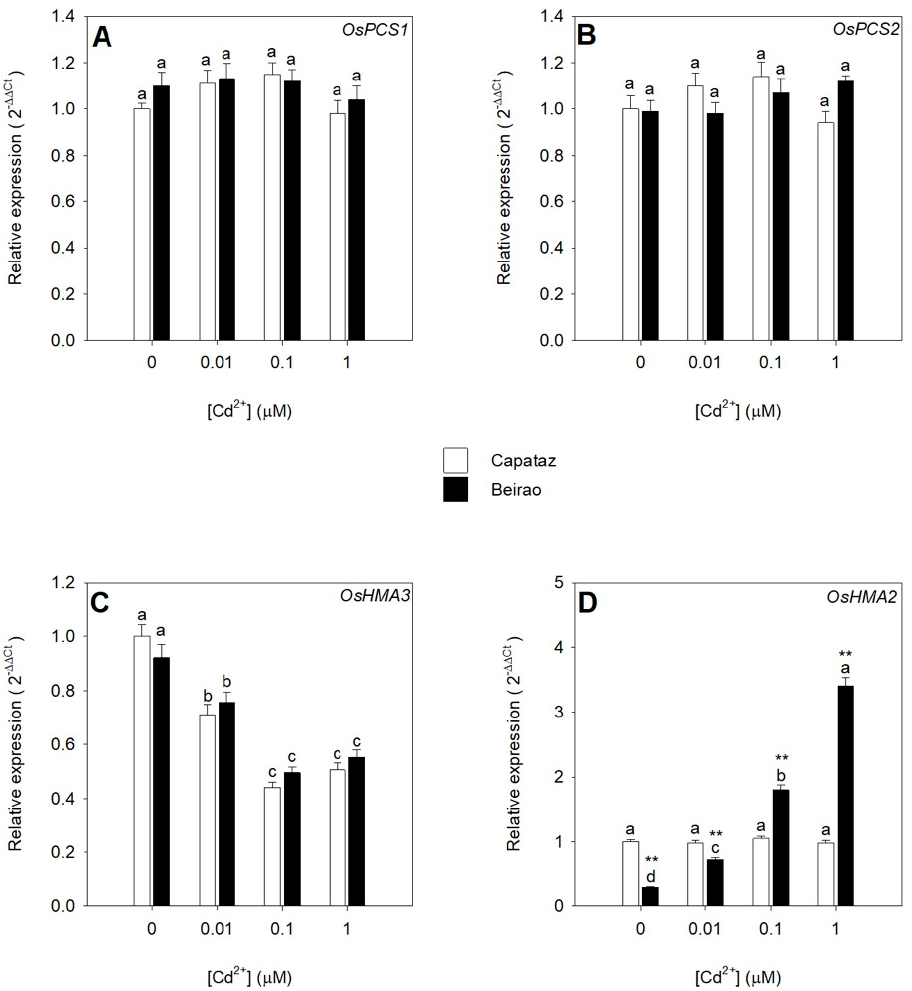
Figure 3. Effects of Cd exposure on the relative transcript abundance of four genes expressed in the roots and involved in Cd root retention. Capataz (white bars) and Beirao (black bars) were exposed to different Cd concentrations (0.01, 0.1, and 1 μ M) for 10 days. qRT-PCR was performed on total RNA extracted from the root tissues. OsPCS1 , Phytochelatin synthase 1 ( A ). OsPCS2 , Phytochelatin synthase 2 ( B ). OsHMA3 , Heavy metal ATPase 3 ( C ). OsHMA2 , Heavy metal ATPase 2 ( D ). Bars and error bars are means and SE of two experiments run in triplicate (n = 6). Different letters indicate significant differences among treatments ( p < 0.05). Asterisks indicate significant differences between Capataz and Beirao (Student’s t -test; ** p < 0.001).